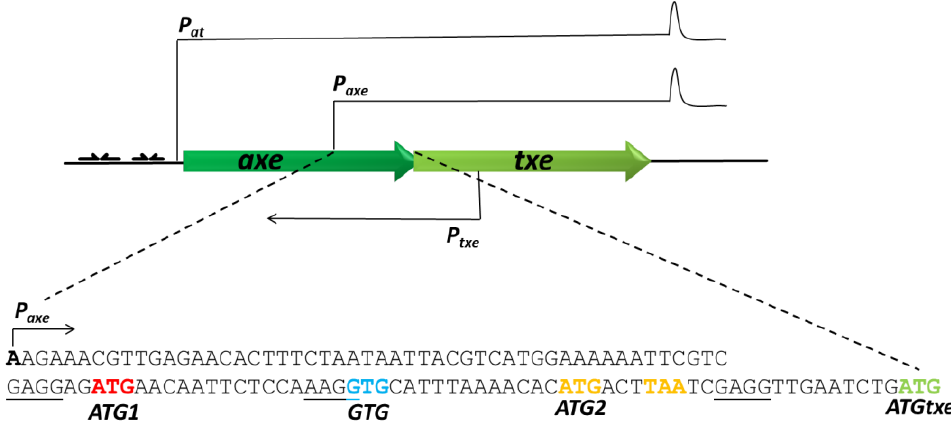
Figure 1. Schematic organization of the axe-txe operon with the nucleotide sequence of the leader transcript produced from the p axe promoter. The axe and txe genes are depicted by green arrows. Transcripts originating from the p at , p axe , and p txe promoters are indicated by thin black lines and arrows. A hairpin structure is present at the end of the p at and p axe transcripts. The leader region of the p axe transcript starts at the p axe transcription start site (black A in bold), while it ends at the ATG codon of the txe gene (ATGtxe) (in green). Within this leader, additional translation start sites (ATG1, GTG, and ATG2) are marked in different colors, along with the stop codon TAA. Potential Shine – Dalgarno sequences are underlined.